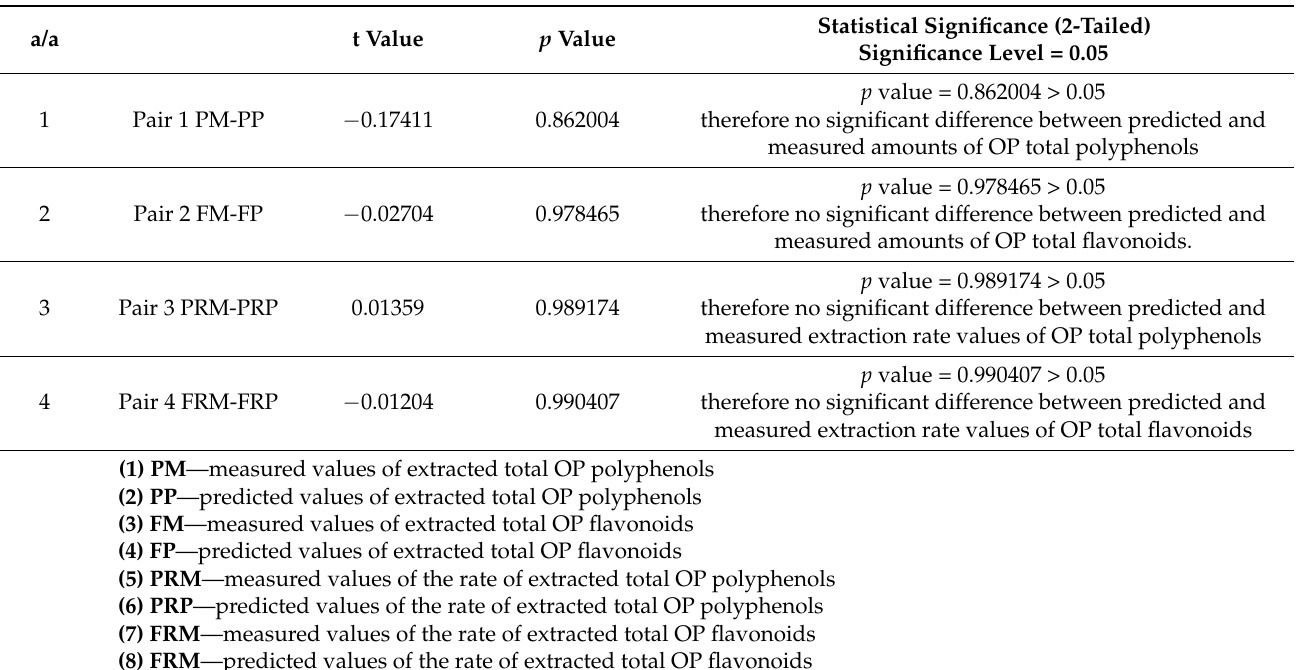
Table 7. Results of the statistical t-test analysis applied between predicted and actual values of the extracted total polyphenols and total flavonoids of orange pomace extracts as well as between the predicted and actual productivities of them. a/a t Value p Value